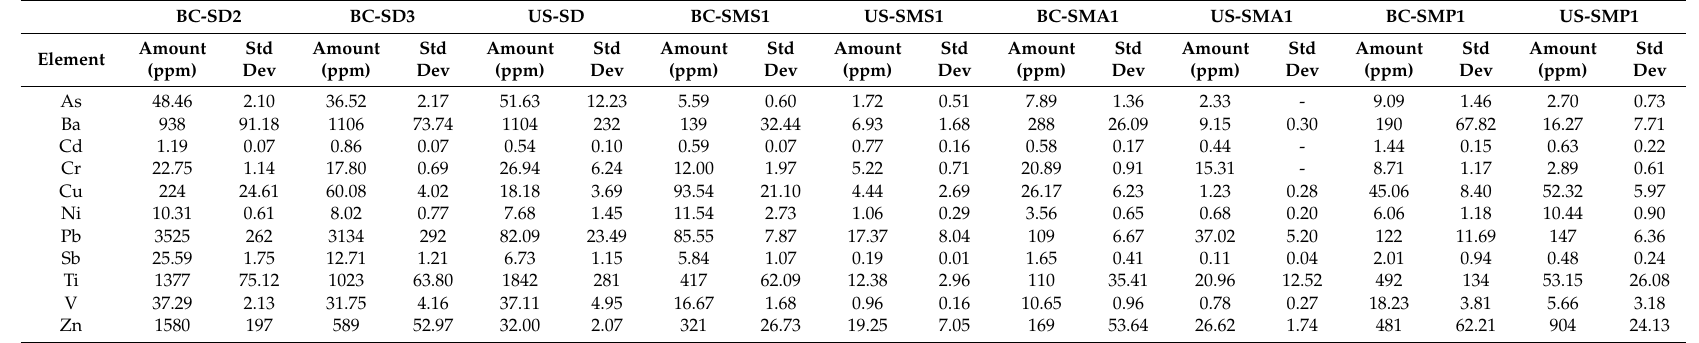
Table 4. The average concentration resulted from five point-analysis (expressed in ppm) of the most representative chemical elements, both in the unaltered substrate (US) and in the black crusts